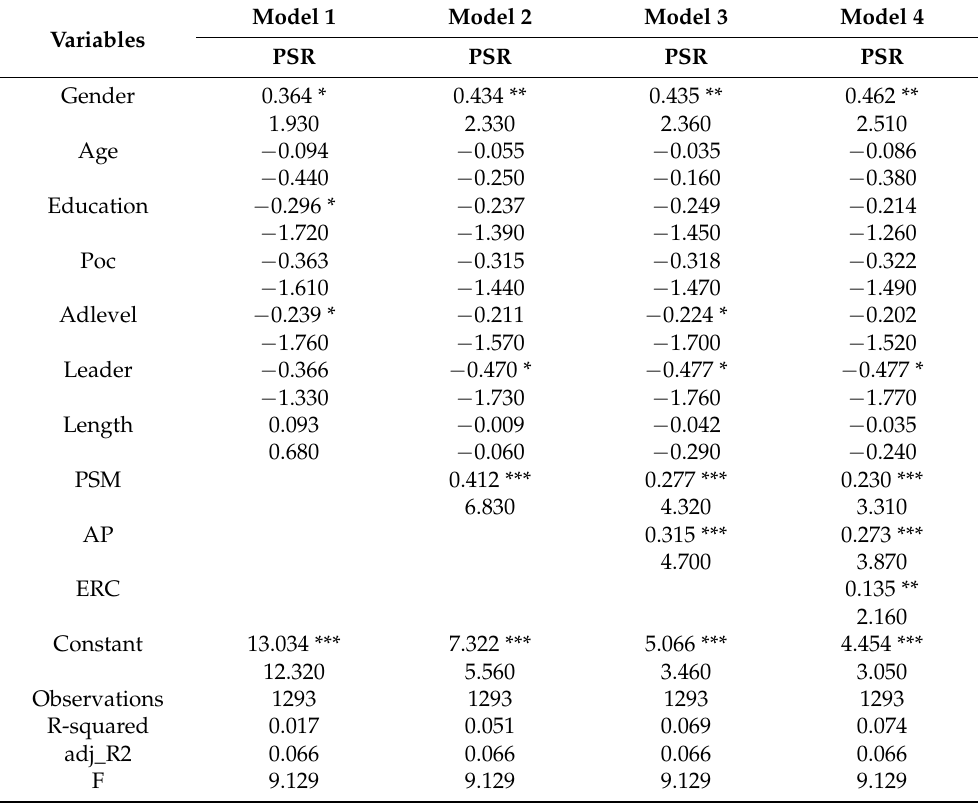
Table 4. The multiple linear regression models ( n =